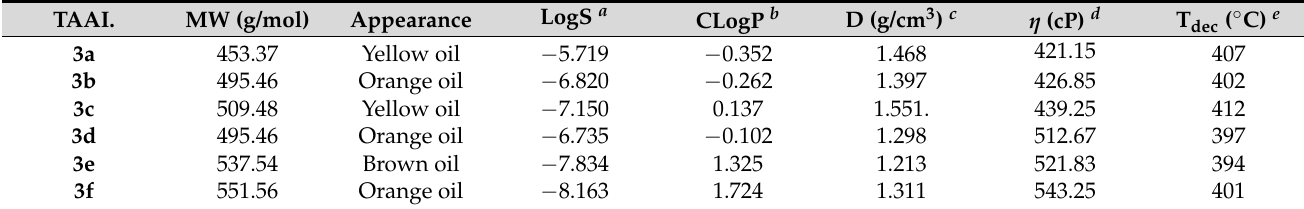
Table 1. Physicochemical characteristics of new